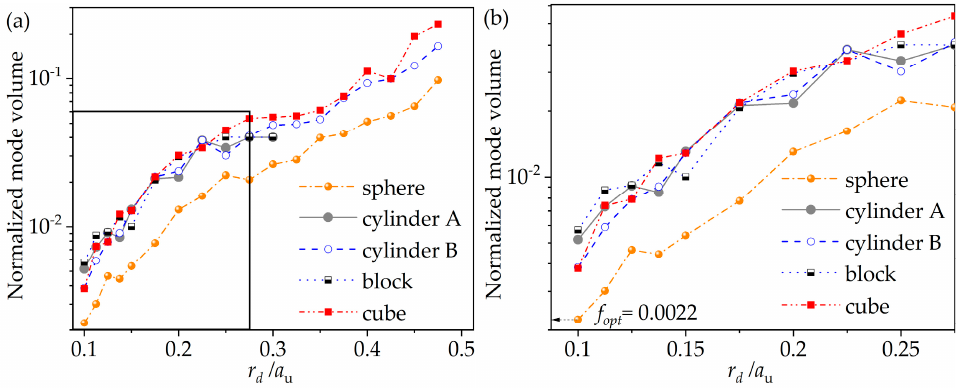
Figure 8. Normalized mode volumes, obtained for the various normalized radii ( r d / a u ) and defect types. ( b ) Zoom-in of the highlighted region in ( a ).